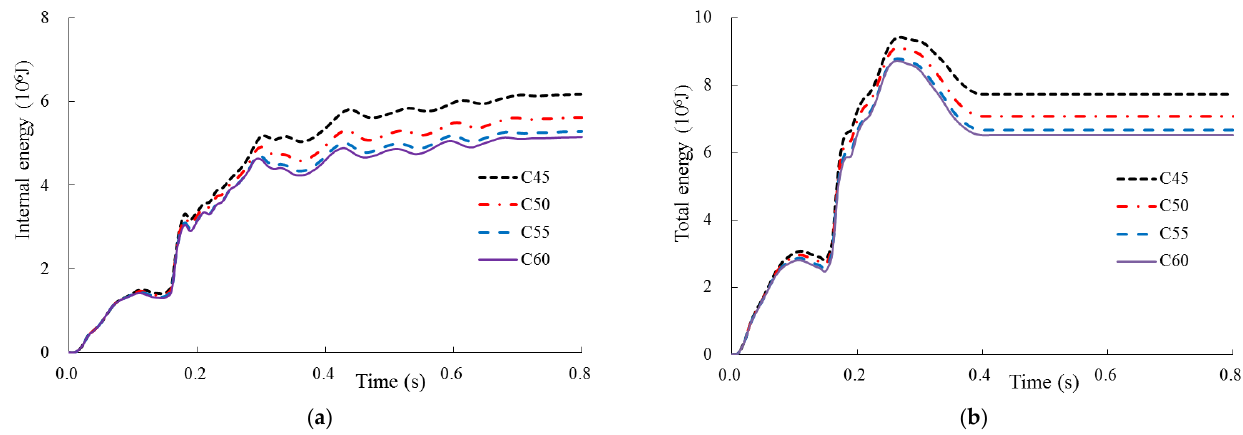
Figure 15. The internal energy of concrete and total energy of containment for different concrete strength grades. ( a ) Internal energy; ( b ) Total energy.